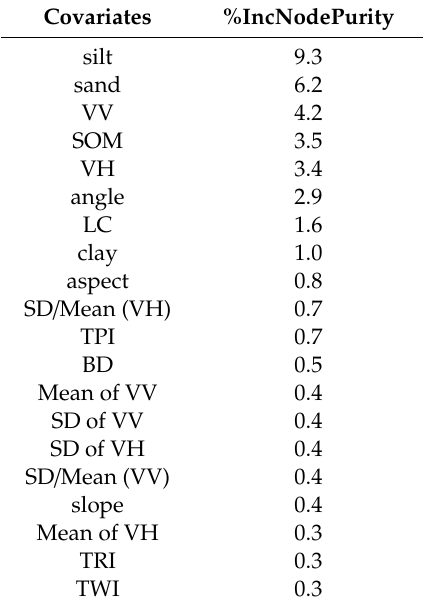
Table 4. Covariates importance in the Random Forest model. Abbreviations: %IncNodePurity means a total decrease in node impurities from splitting on the variable, averaged over all trees; VH, backscatter measured in vertical transmit / horizontal receive mode; VV, backscatter measured in vertical transmit / vertical receive mode; Mean and SD of VV and VH refer to the temporal mean and temporal standard deviation values of VV and VH backscatter measurements during 2016–2018; TPI, topographic position index; TRI, terrain ruggedness index; TWI, topographic wetness index; BD, bulk density; SOM, soil organic matter; and LC, land cover. Covariates %IncNodePurity silt 9.3 sand